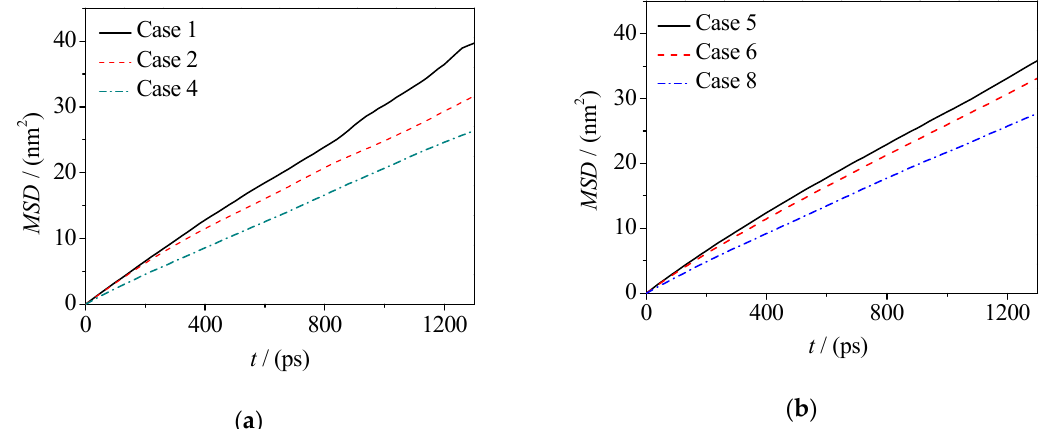
Figure 8. Mean displacement curve of water molecules in: ( a ) Fluorobenzene–NaCl aqueous solution system; ( b ) 1-Pentanol–NaCl aqueous solution system.